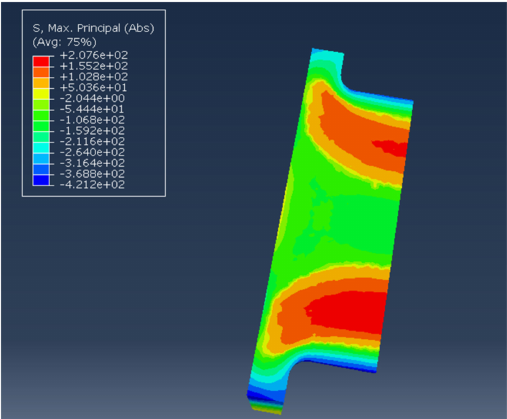
Figure 13. The residual stress field distribution of the